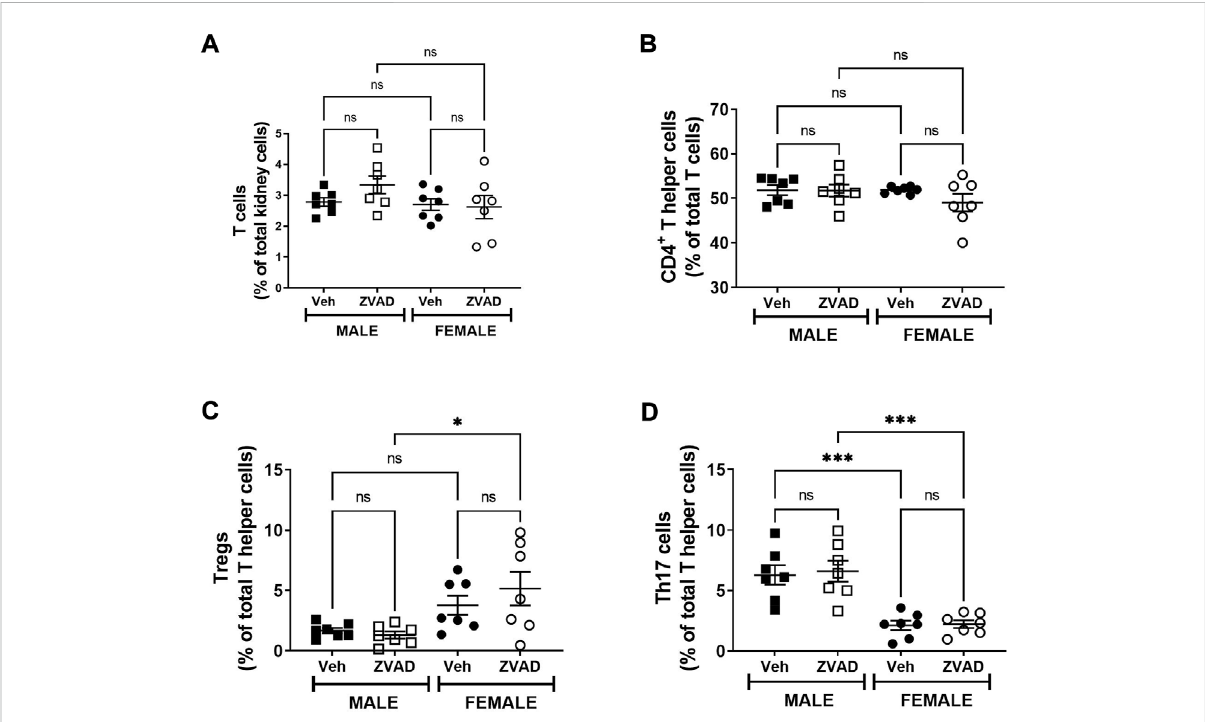
FIGURE 9 TreatmentwithZVAD-FMK for6 weeksdidnotchangeeithersplenicorrenal Tcellpro fi le.Tcellsweremeasuredinkidneysisolatedfrommale and female spontaneously hypertensive rats (SHR) treated with vehicle (veh) or ZVAD-FMK (ZVAD) from 6 to 12 weeks of age ( n = 7). The following T cells were measured: total CD3 + T cells [panel (A) ], CD4 + T helper cells [panel (B) ], T regulatory cells [Tregs; CD3 + CD4 + FOXP3 + ; panel (C) ] and T helper (Th17 cells [CD3 + CD4 + ROR- γ + ; panel (D) ]. CD3 + T cells were expressed as % total renal cells. CD4 + T cells were expressed as % total CD3 + T cells. Tregs and Th17 cells were expressed as % CD3 + CD4 + T cells. Data were compared using 2-Way ANOVA followed by Tukey ’ s multiple comparisons test; *** indicates p < 0.001; * indicated p < 0.05; NS indicates not signi fi